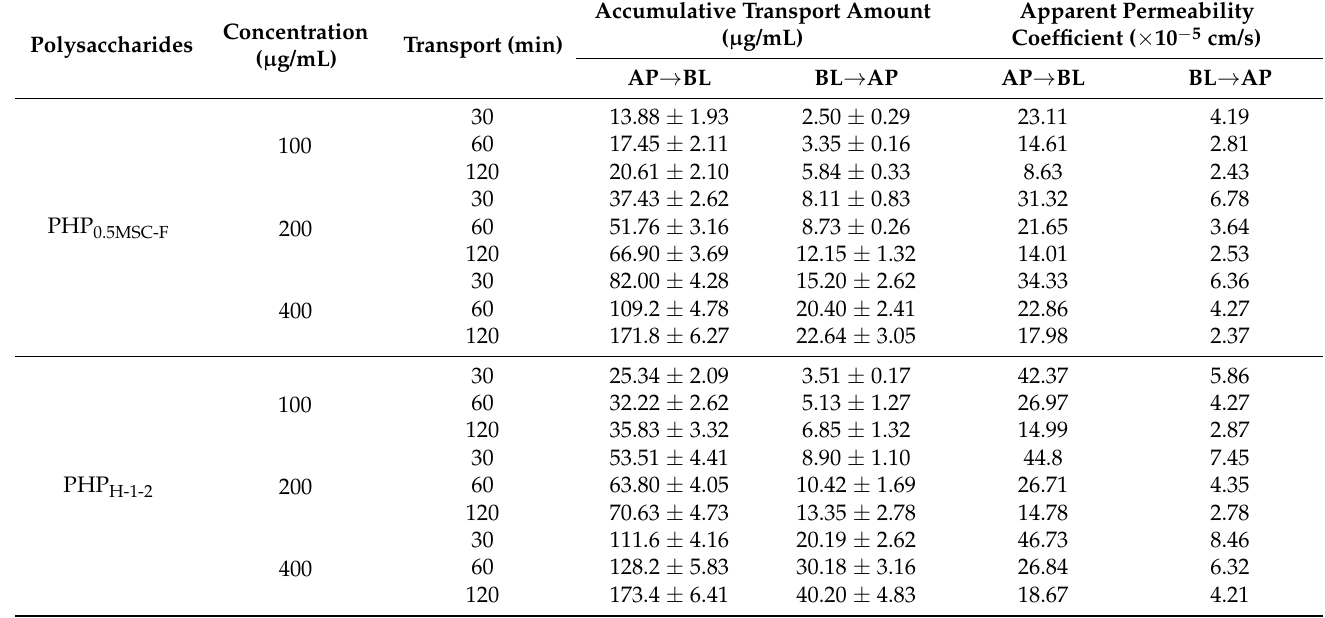
Table 2. Accumulative transport amount and apparent permeability coefficient of PHP 0.5MSC-F and PHP H-1-2 in the caco-2